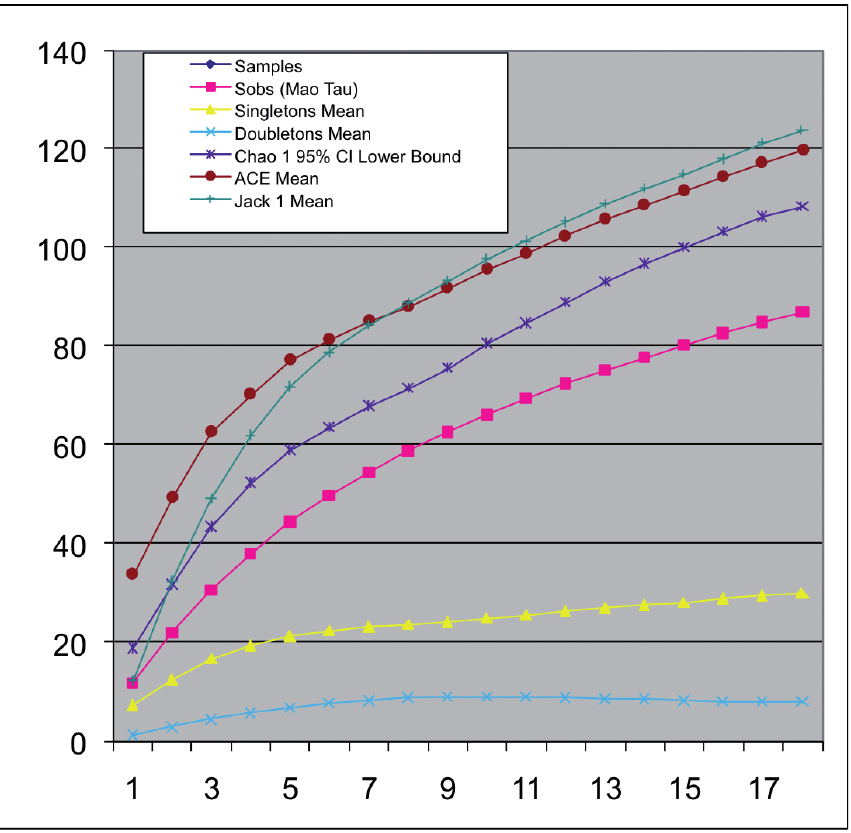
Fig. 237. Species accumulation curve: number of species in relation to the number of sampled habitats